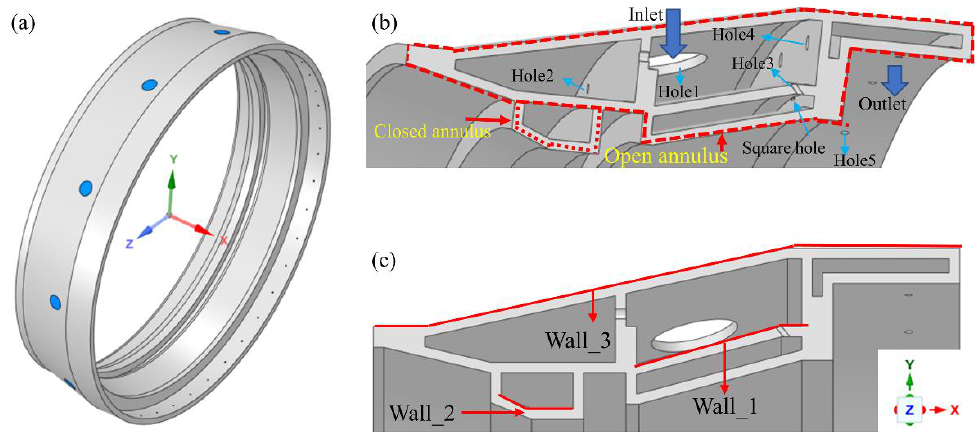
Figure 1. Structure of the casing model: ( a ) 3D view of the casing; ( b ) sectional view of the casing model; ( c ) names of some of the surfaces of the casing.